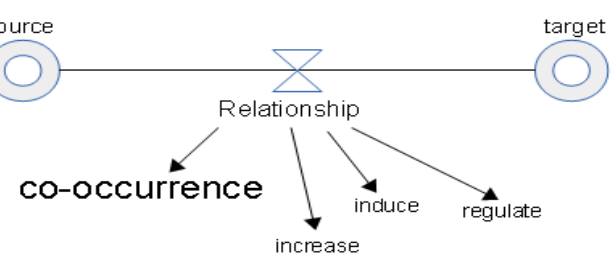
Figure 4. Graphical representation of an extracted